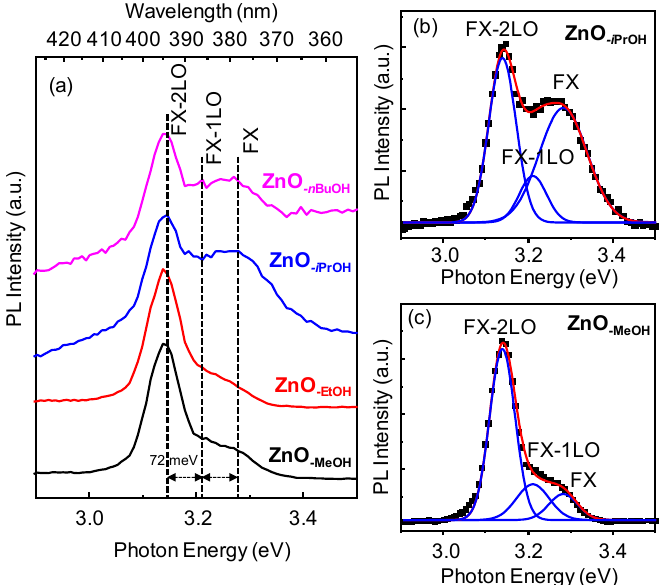
Figure 13. ( a ) PL spectra of ZnO -ROH (R = Me, Et, i Pr and n Bu) NPs in the UV range, ( b ) and ( c ) spectral fitting of the peaks for ZnO - i PrOH and ZnO -MeOH , respectively.